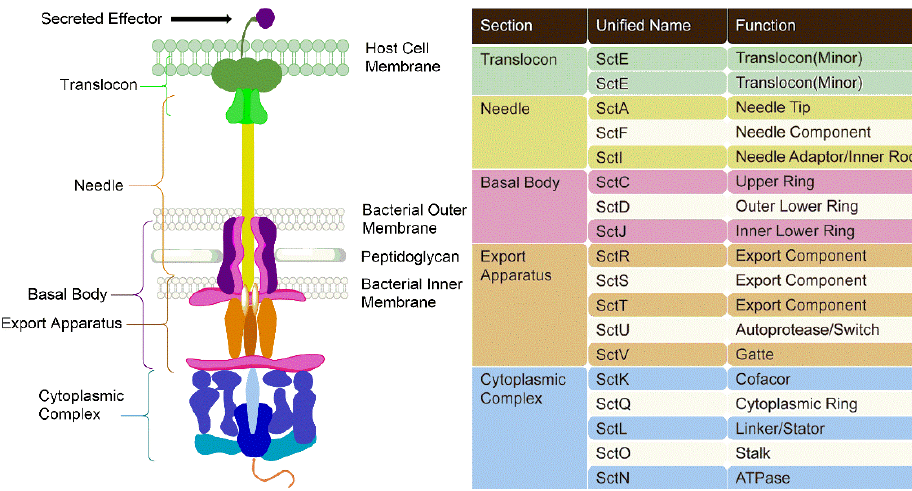
Figure 1. The general structure of the T3SS. ( Left ): Cross section of a prototypical T3SS with color- coded and labeled sections. ( Right ): Table of unified names of T3SS structural components by sec- tion [12,41].